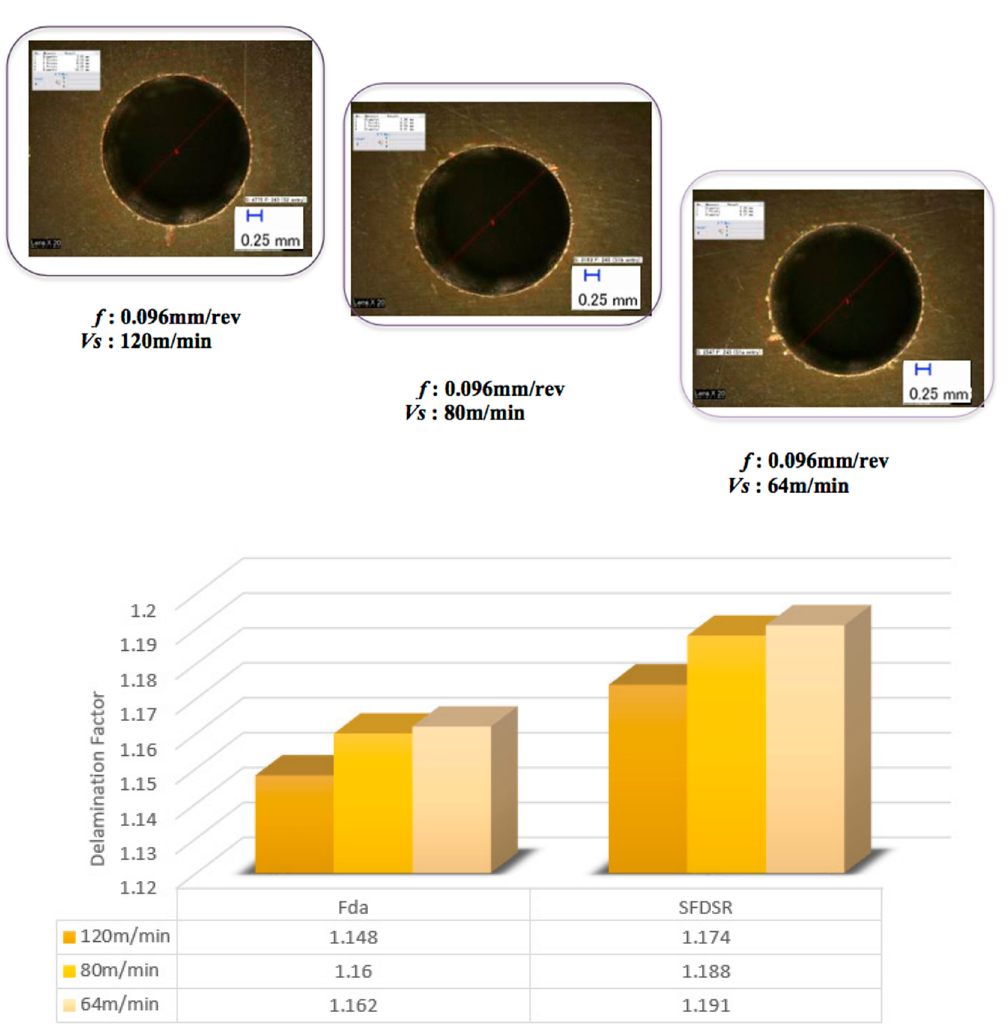
Figure 6. Delamination factor results when drilling at a constant feed rate of 0.09 m/rev.